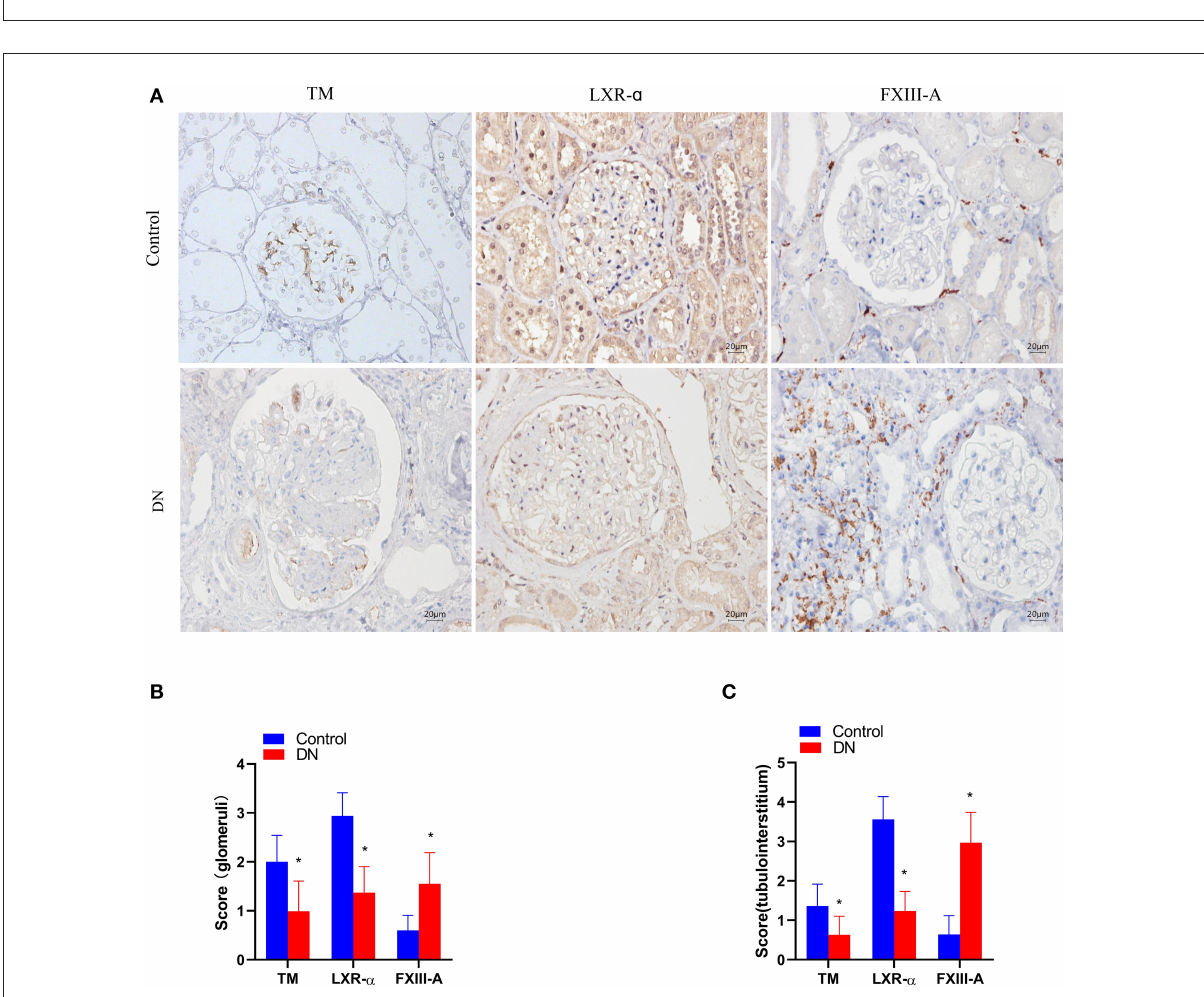
FIGURE2 The expression of TM, LXR- α and FXIII-A in the renal tissue of DN patients. (A) Representative images of immunohistochemical staining of TM, LXR- α , and FXIII-A. Scale bar = 20 µ m. (B, C) Score of positive staining for TM, LXR- α and FXIII-A in the kidney tissue ( n = 15, mean ± SEM). * p < 0.05 compared with the Control